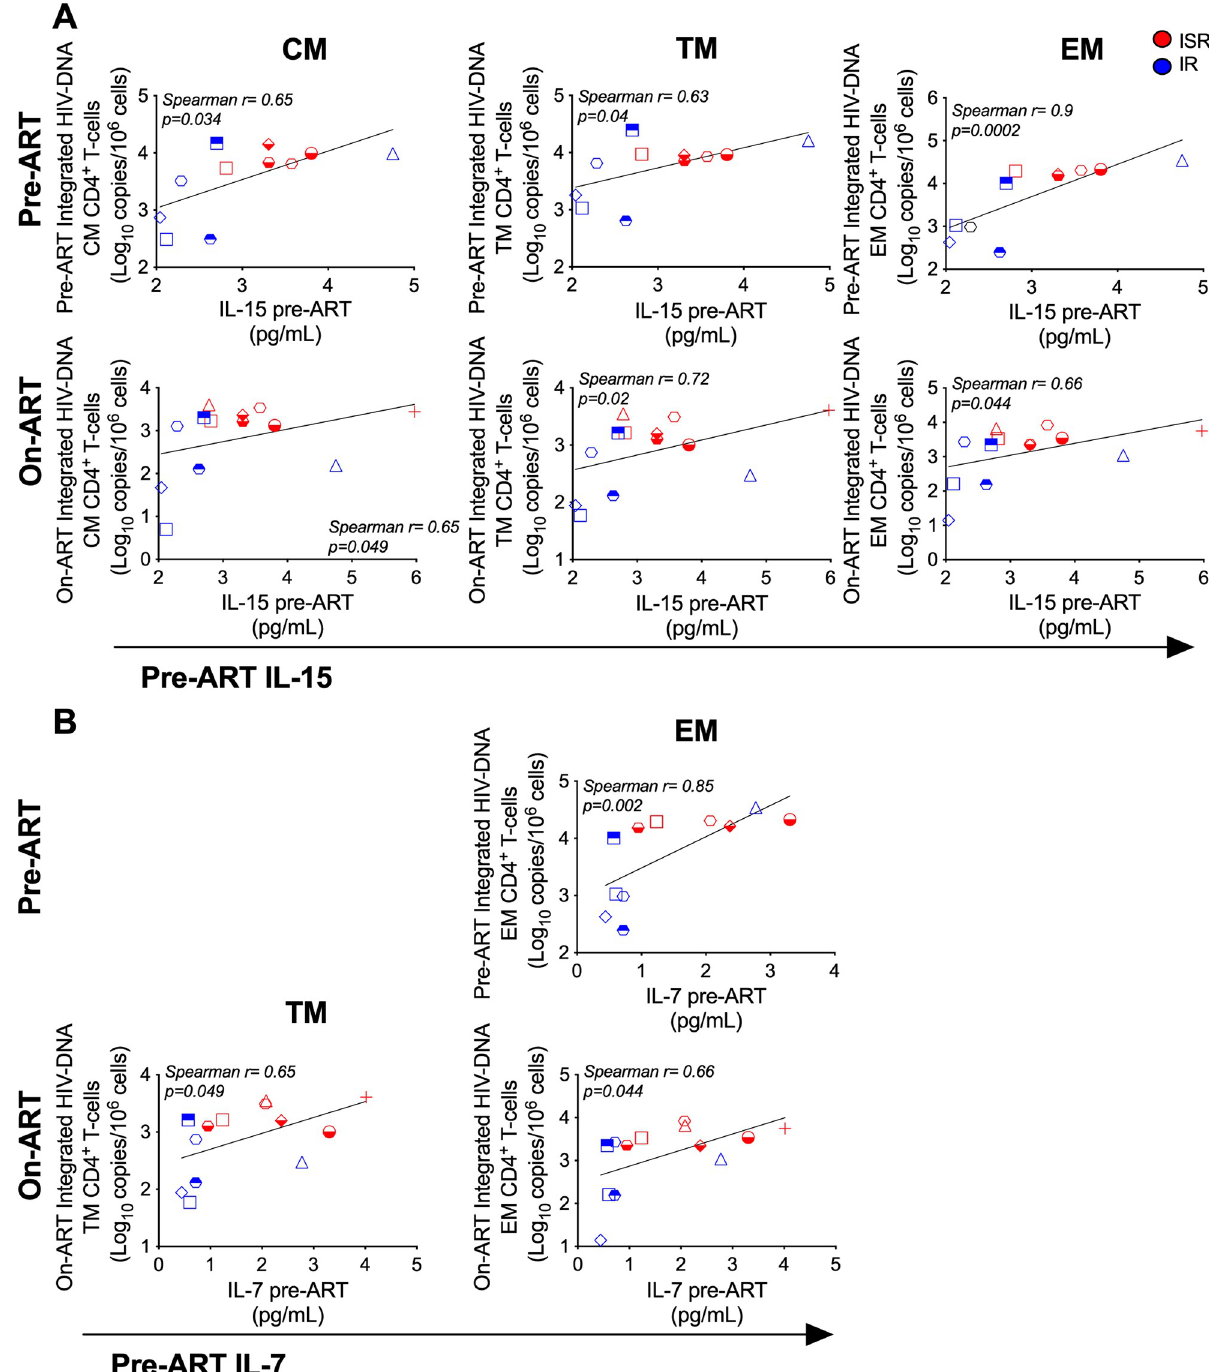
Fig 4. Pre-ART IL-15 and IL-7 plasma cytokine levels correlate with HIV reservoir in blood CM, TM, and EM subsets at pre-, and on-ART. (A) Correlation of IL-15 pre-ART cytokine plasma levels with integrated HIV-DNA in CD4 T-cell subsets at pre-ART (top panels, n = 11; IR n = 6, ISR n = 5), and on-ART (bottom panels, n = 13; IR n = 6, ISR n = 7). (B) Correlation of IL-7 pre-ART cytokine plasma levels with integrated HIV-DNA in CD4 T-cell subsets at pre-ART (top panels, n = 11; IR n = 6, ISR n = 5), and on-ART (bottom panels, n = 13; IR n = 6, ISR n = 7). Blue indicates IR, red indicates ISR. CD4 T-cell subsets included na ï ve (N), central memory (CM), transitional memory (TM), and effector memory (EM) cells. Spearman rank correlation test was used to determine correlations among all individuals.